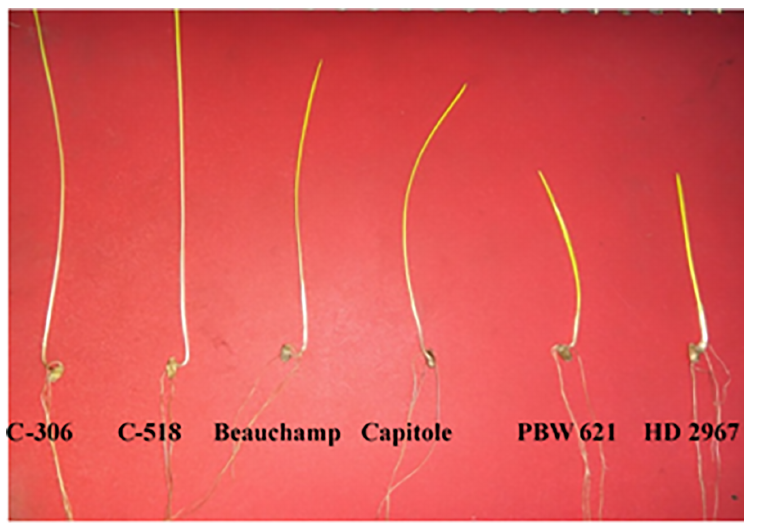
Fig 1. CL and SL of some cultivars.